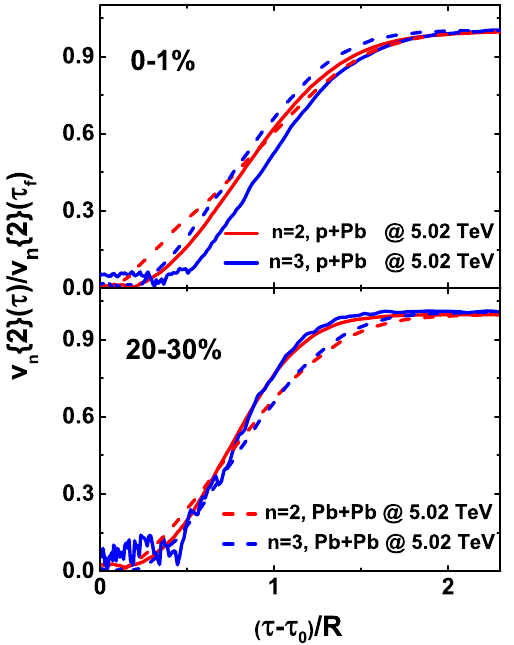
Fig. 4 Time evolution of v 2 and v 3 as a function of time normalized to the mean square root size of the systems p + Pb (solid lines) and Pb + Pb (dashed lines) at two different centralities: 0-1% (upper panel) and 20-30% (lower panel)